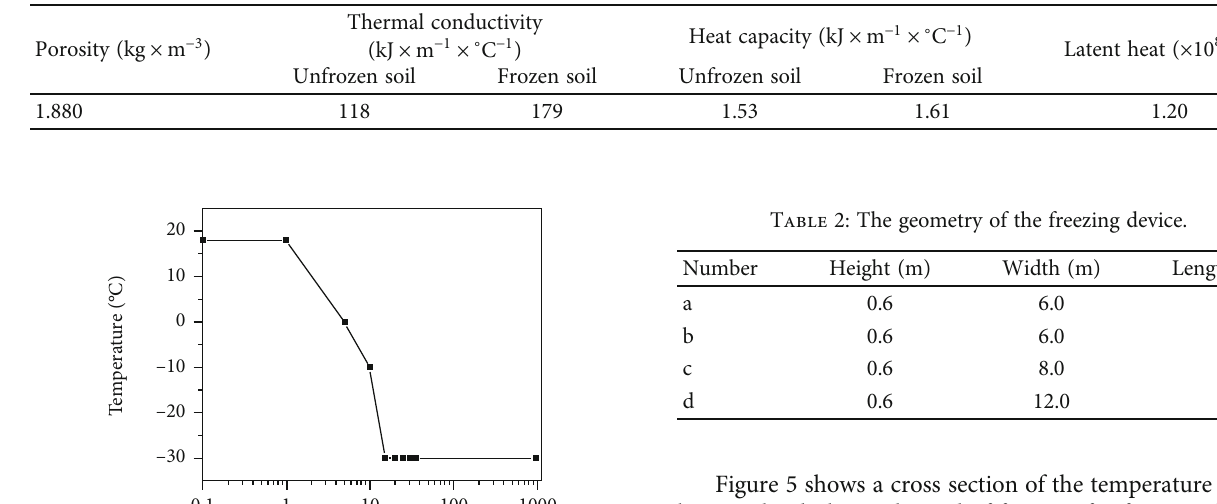
Figure 3: Schematic of the freezing device. Table 1: Soil parameters.